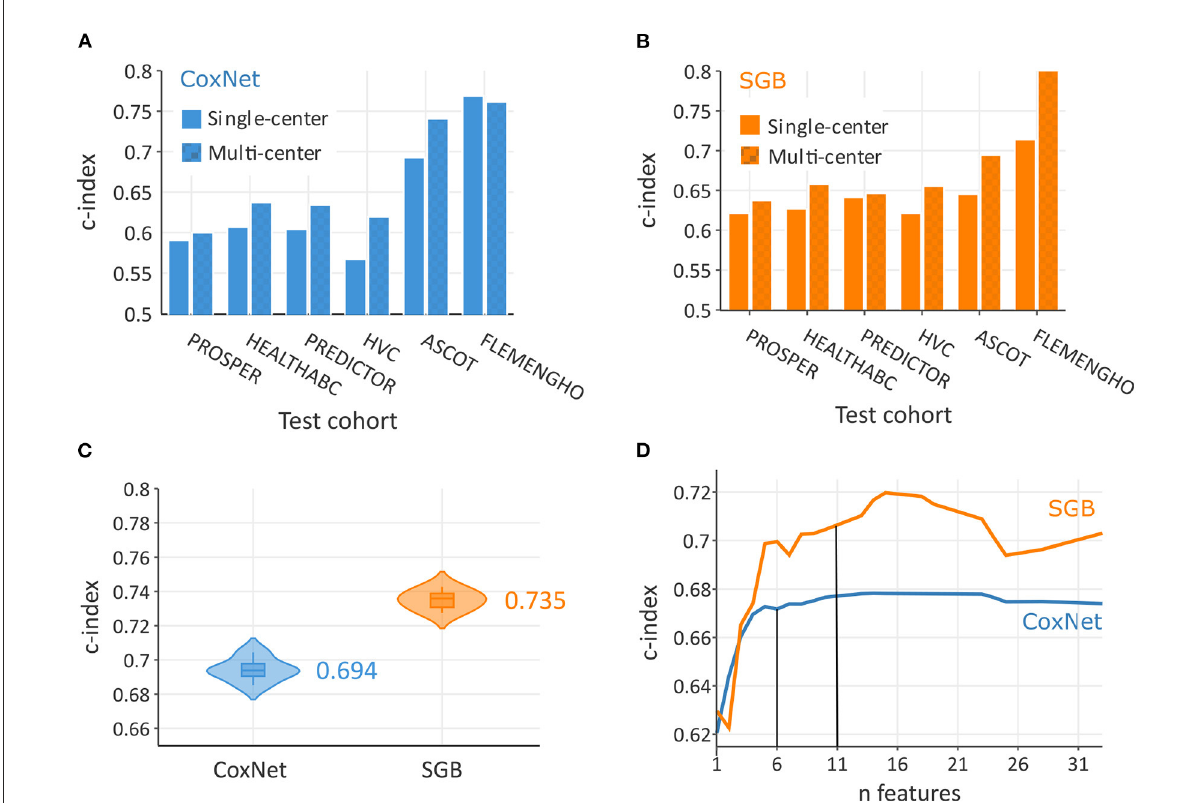
FIGURE2 Predictive performance increased with multi-rather than single-cohort training data both in CoxNet (A) and survival gradient boosting (SGB) (B) . On the pooled dataset, SBG achieved a greater overall c-index than CoxNet (C) . In terms of number required features to achieve maximum predictive performance, SBG required 11 features and CoxNet 6 features (D) .